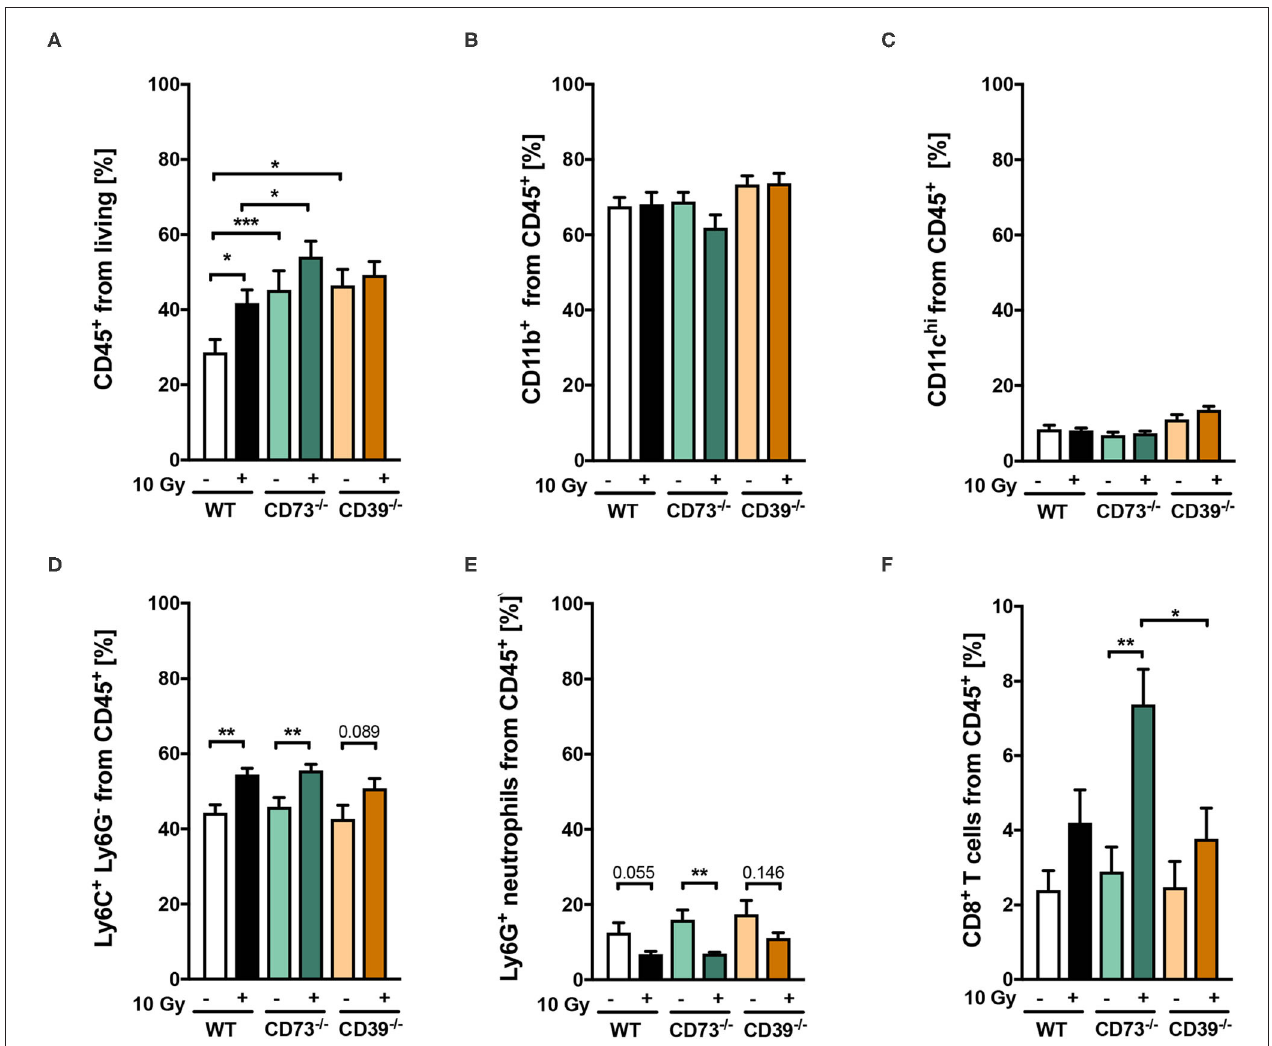
FIGURE 4 | (A–F) Host CD39 deficiency causes only subtle changes in radiation-induced tumor immune cell infiltration. LLC1 tumor cells (0.5 × 10 6 cells each) were subcutaneously transplanted onto the hindlimb of C57BL/6 wild-type (white/black) CD73-knockout (CD73 − / − ; green, triangles) and CD39-knockout mice (CD39 − / − ; orange circles) mice. Hind-leg single-dose irradiation with 0 or 10Gy was conducted at the timepoint of tumor manifestation. Three days after irradiation, tumors were dissected, and single-cell suspensions were generated. Tumor-infiltrating leukocytes were analyzed via flow cytometry. Shown in bar diagrams are the percentages of diverse immune cell populations. Shown are means ± SEM, * P ≤ 0.05, ** P ≤ 0.01, *** P ≤ 0.001, analyzed by one-way ANOVA followed by a post hoc Tukey test, n = (13/14) (C57BL/6), (9/9) (CD73 − / − ), (10/9) (CD39 − / −